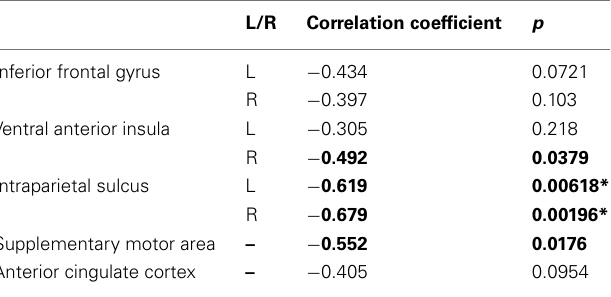
Table 2 | Correlation between p (choose safe option) and activation with safe–risky choice contrast.